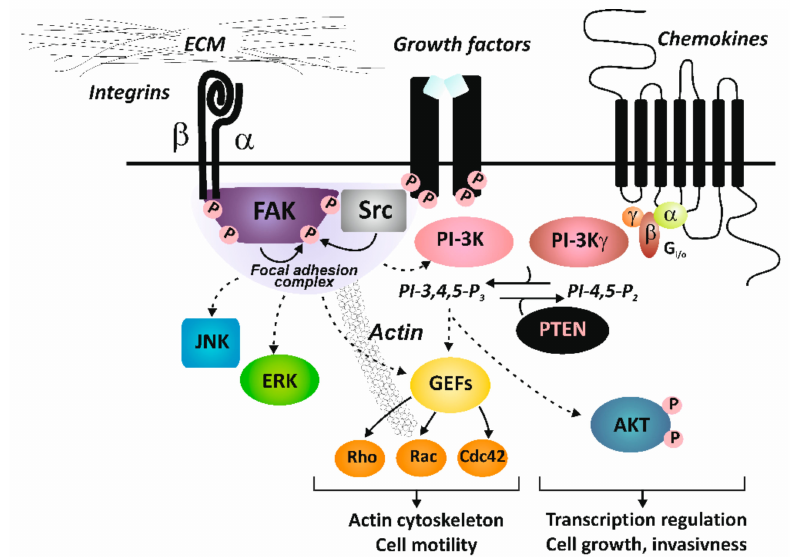
Figure 2. Integrin signaling. Abbreviations: AKT, AKT8 virus oncogene cellular homolog, kinase; ECM, extracellular matrix; ERK, extracellularly activated kinase; FAK, focal adhesion kinase; GEFs, guanine nucleotide exchange factors; JNK, c-Jun N-terminal kinase; PI-3K, phosphoinositide-3- kinase; PTEN, phosphatase and tensin homologue deleted on chromosome 10, tumor suppressor; Src, Rous sarcoma oncogene cellular homolog,